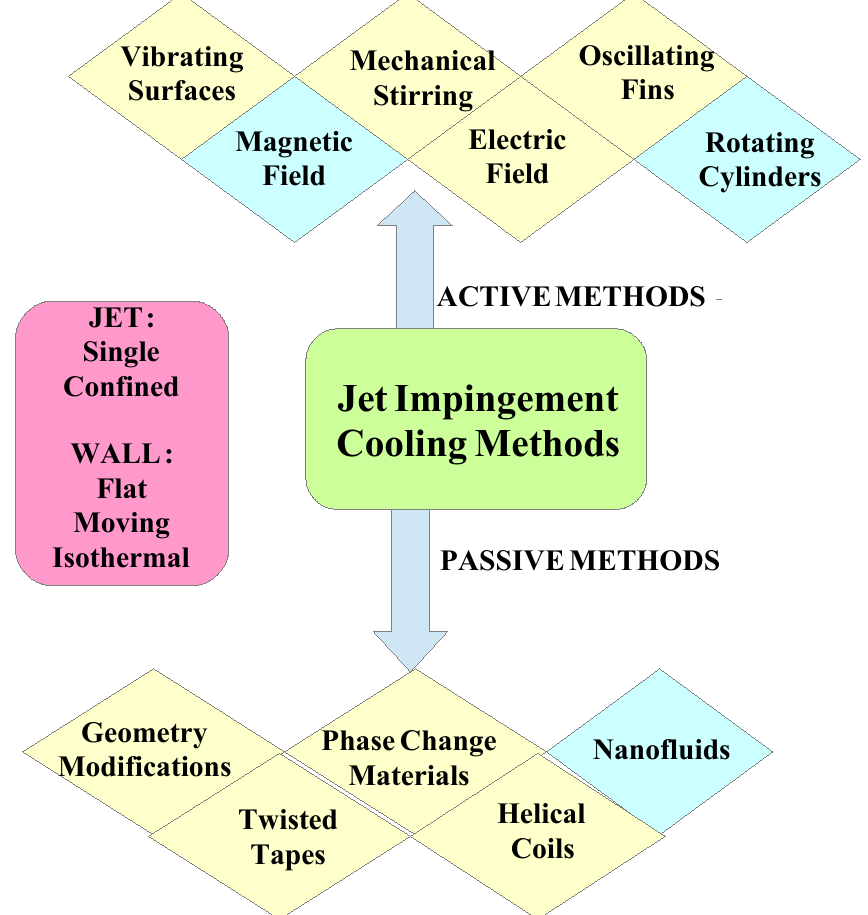
Figure 1. Different available methods that can be used for flow control and thermal performance improvement of jet impingement